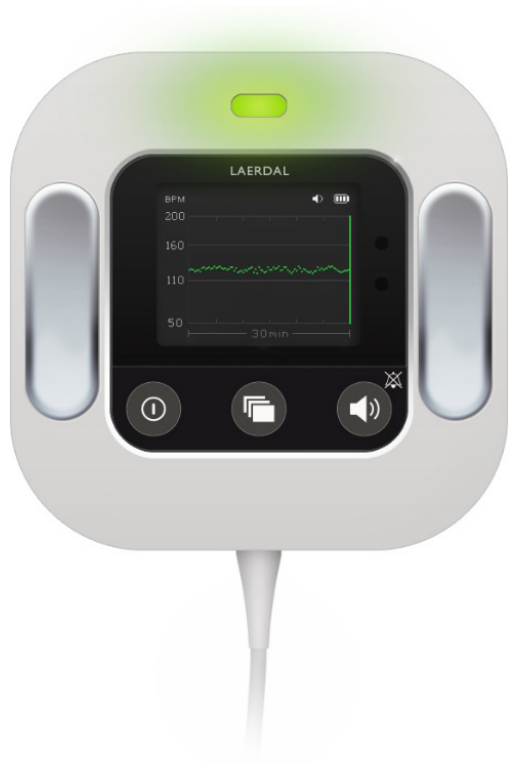
Figure 2. The Moyo FHR monitor with a 30-minutes historical display (Laerdal Global Health).